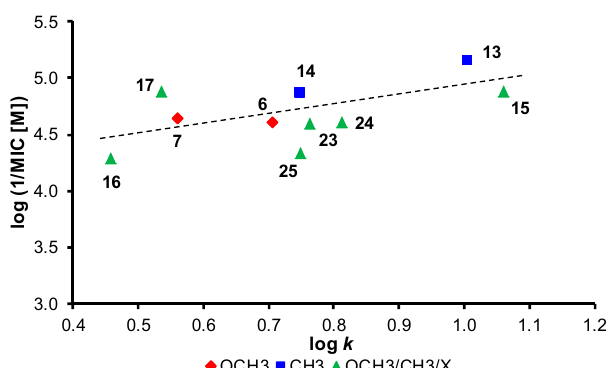
Figure 4. Dependence of antimycobacterial activity of tested compounds against M. tuberculosis expressed as log(1/MIC [M]) on lipophilicity expressed as log k after elimination of non-active compounds.